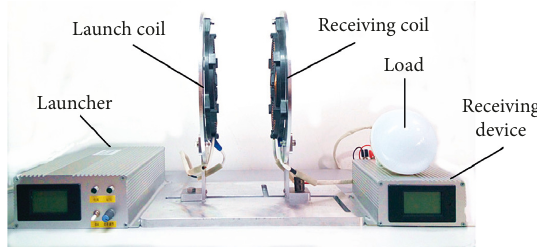
Figure 12: Physical diagram of MCRETS.